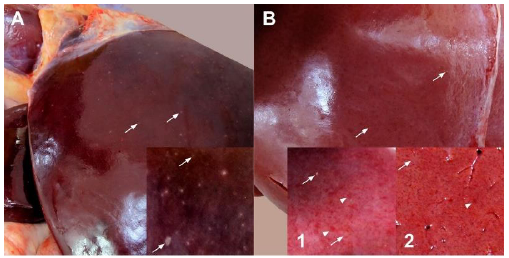
Figure 4. Gross pathology of acute post-infection, time-point livers from virus-inoculated cattle. ( A ) This liver from SA01-inoculated, 3 dpi, Animal #43 shows the typical acute time-point hepatic pathology seen in the 3–5 dpi animals regardless of virus inoculum. Disseminated throughout the parenchyma are myriads of 1–2-mm tan foci (white arrows), necrosis. ( B ) This liver from severely affected Ken06-inoculated, 4 dpi, Animal #38 is diffusely pale. Disseminated throughout the parenchyma are multifocal to coalescing foci of necrosis (white arrows) and hemorrhage (white arrowheads). Inset 1 is a capsular liver view similar to the inset in (A), while Inset 2 shows a cross-section of hepatic parenchyma.